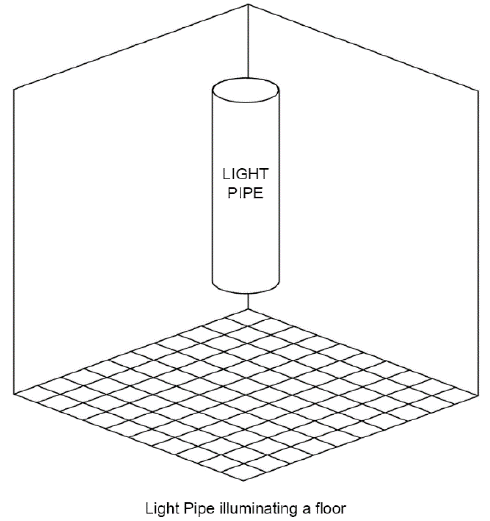
Figure 1. Ground and vertical walls or windows.